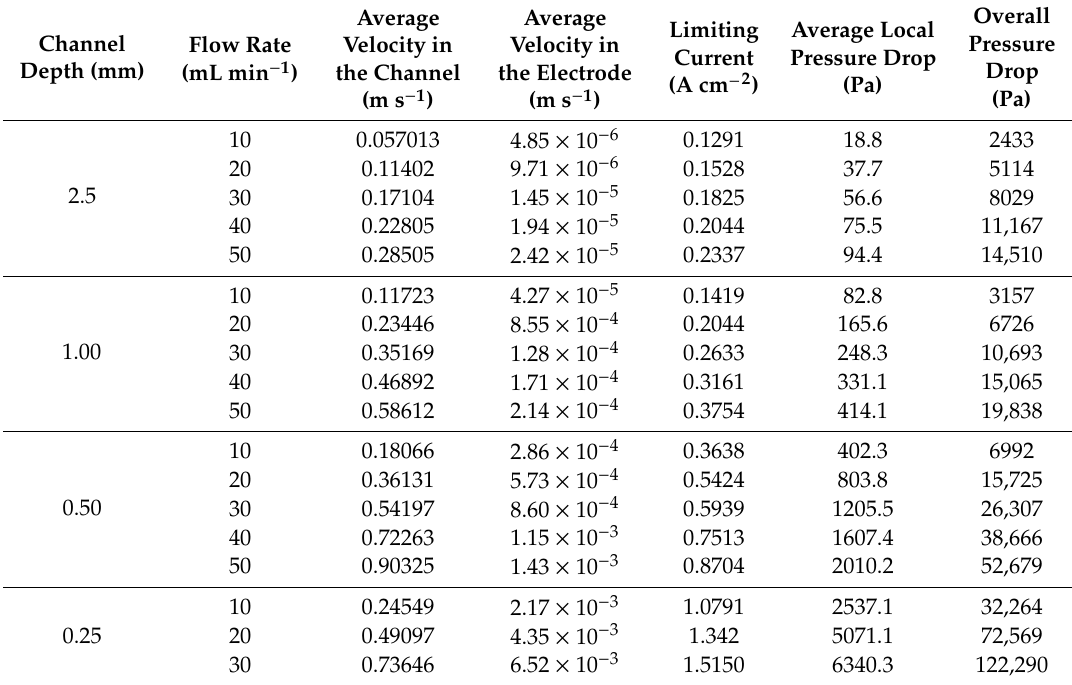
Table 2. Selected parameters for the range of channel depths and flow rates considered in this work. Limiting current is the current achieved at 0.2 V discharge for a 50% SOC